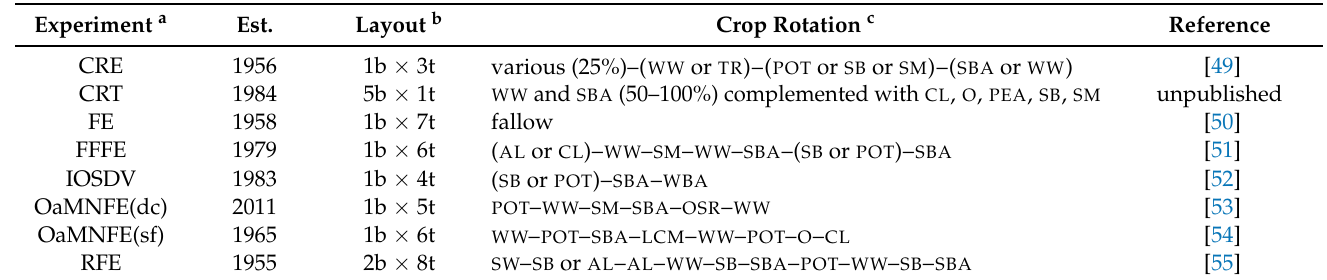
Table 1. Characteristics of the long-term field